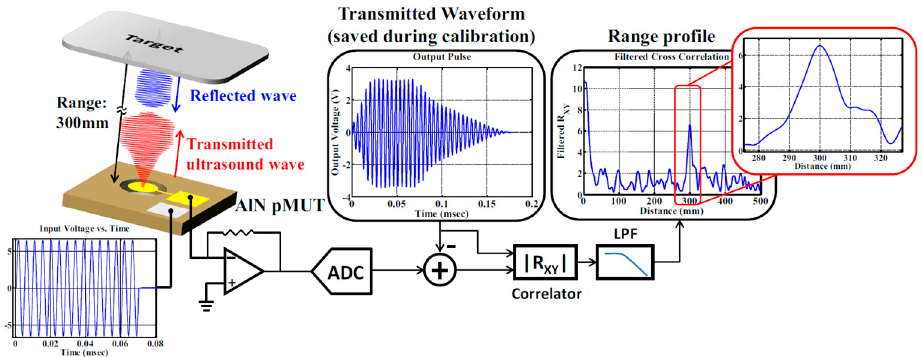
Figure 13. Block diagram of a pMUT rangefinder system using the cross correlation TOF method. Reproduced with permission from [33] , Copyright 2010, IEEE.